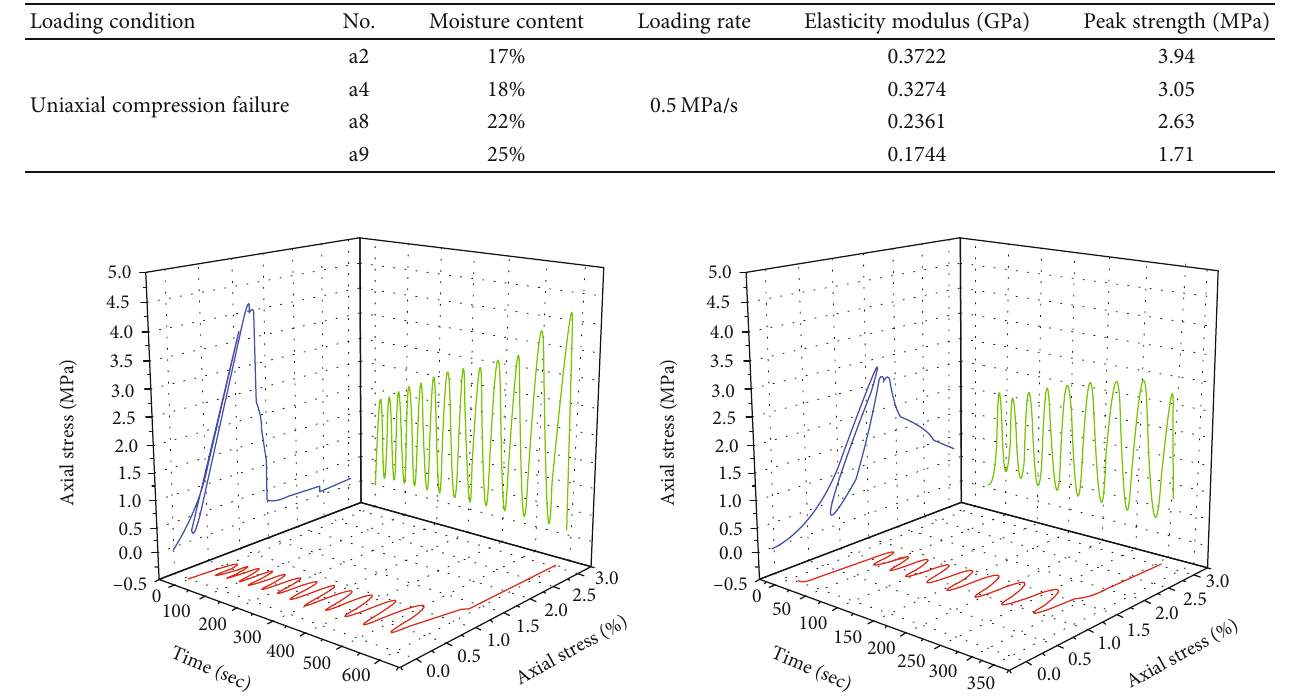
Table 2: Mechanical parameters of some coal samples.